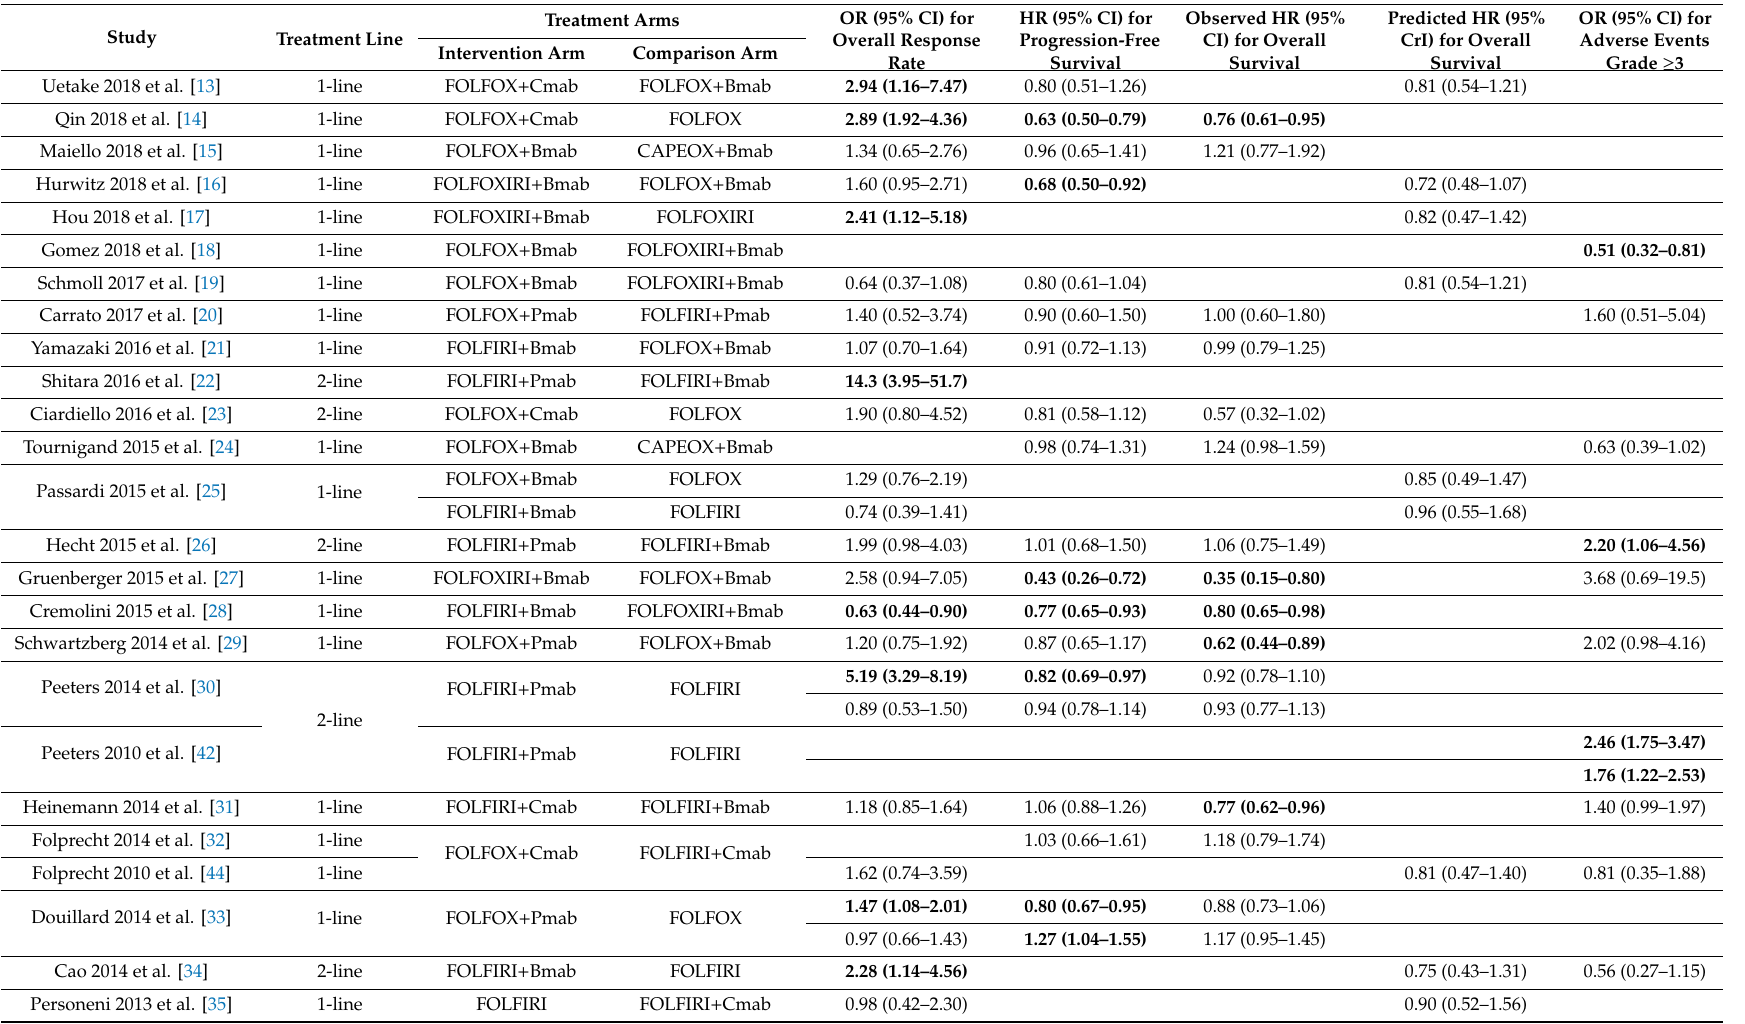
Table 1. Individual study characteristics and treatment e ff ect predictions on correlated